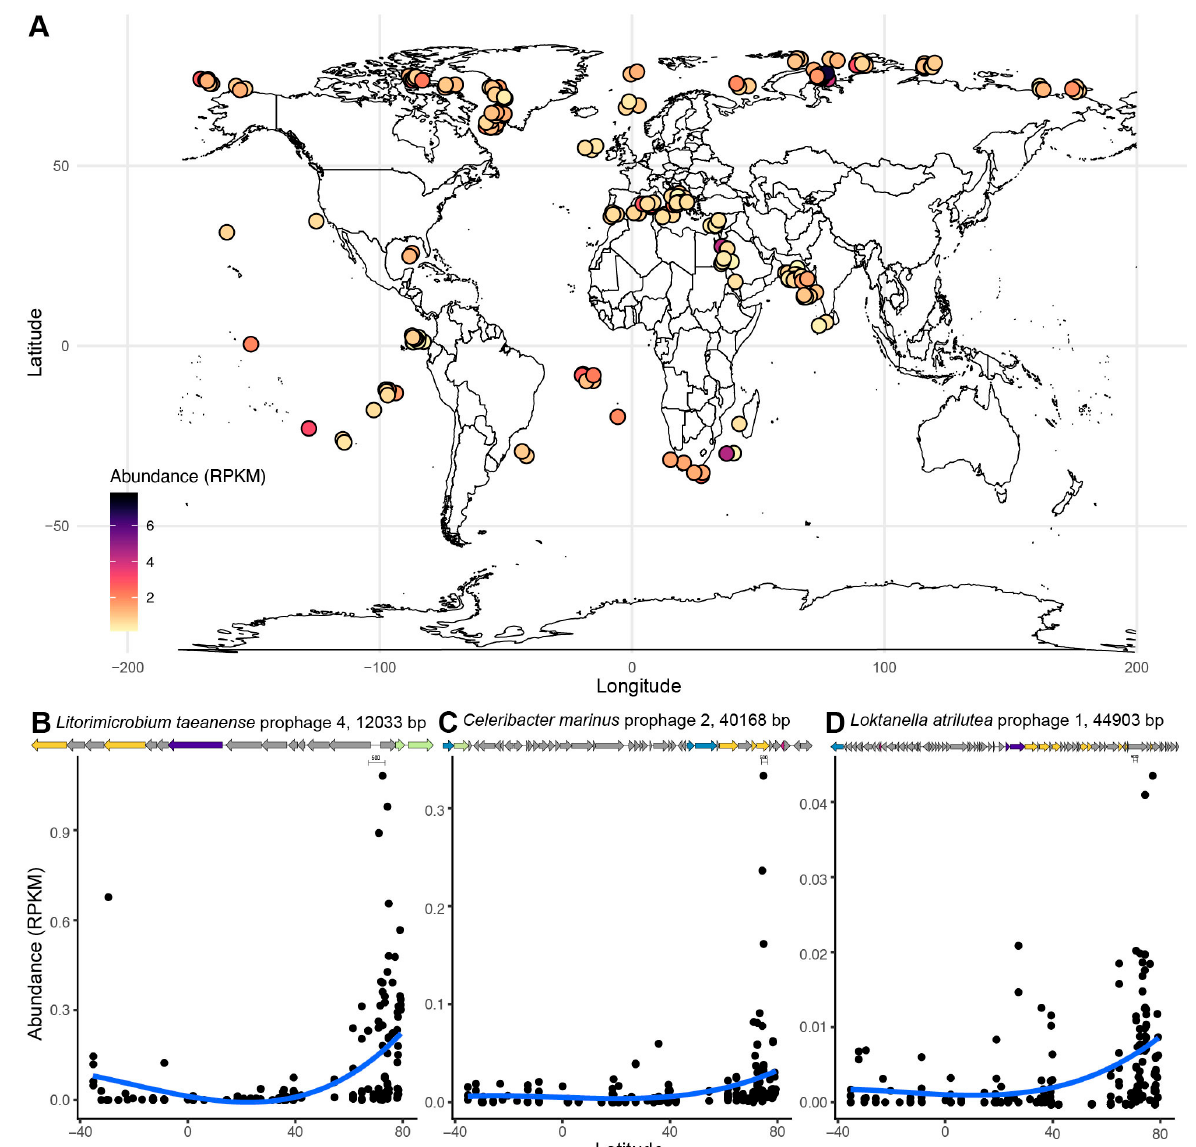
Figure 6. Roseobacter prophage distribution is significantly associated with latitude and temperature. Global distribution of high and medium quality predicted roseobacter prophages in 200 TARA Oceans viral metagenomes. ( A ) The abundance of each prophage in the virome was expressed as reads per kilobase per million (RPKM) and visualized in R using the mapdata package [87]. ( B – D ) Putative prophages significantly associated with both temperature and latitude according to a supervised random forest: Litorimicrobium taeanense prophage 4, Celeribacter marinus prophage 2, and Loktanella atrilutea prophage 1. The colors in the genome maps of these prophages indicate: structural genes in yellow, terminase in blue, integrase or recombinase in purple, AMG in pink, and unknown function in gray.